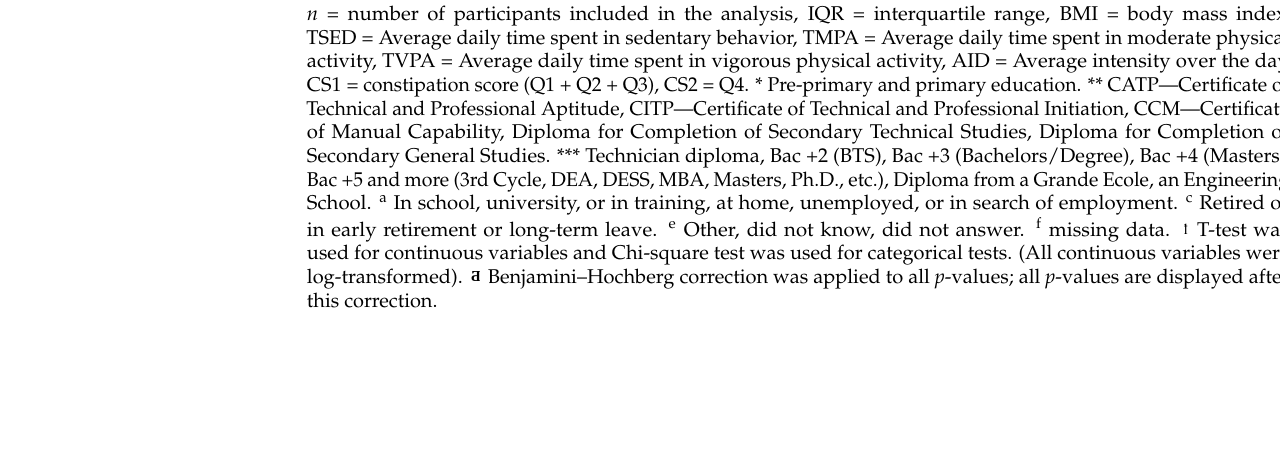
Table 3. Distribution (median and IQR) of food group consumption per day according to gender and constipation score